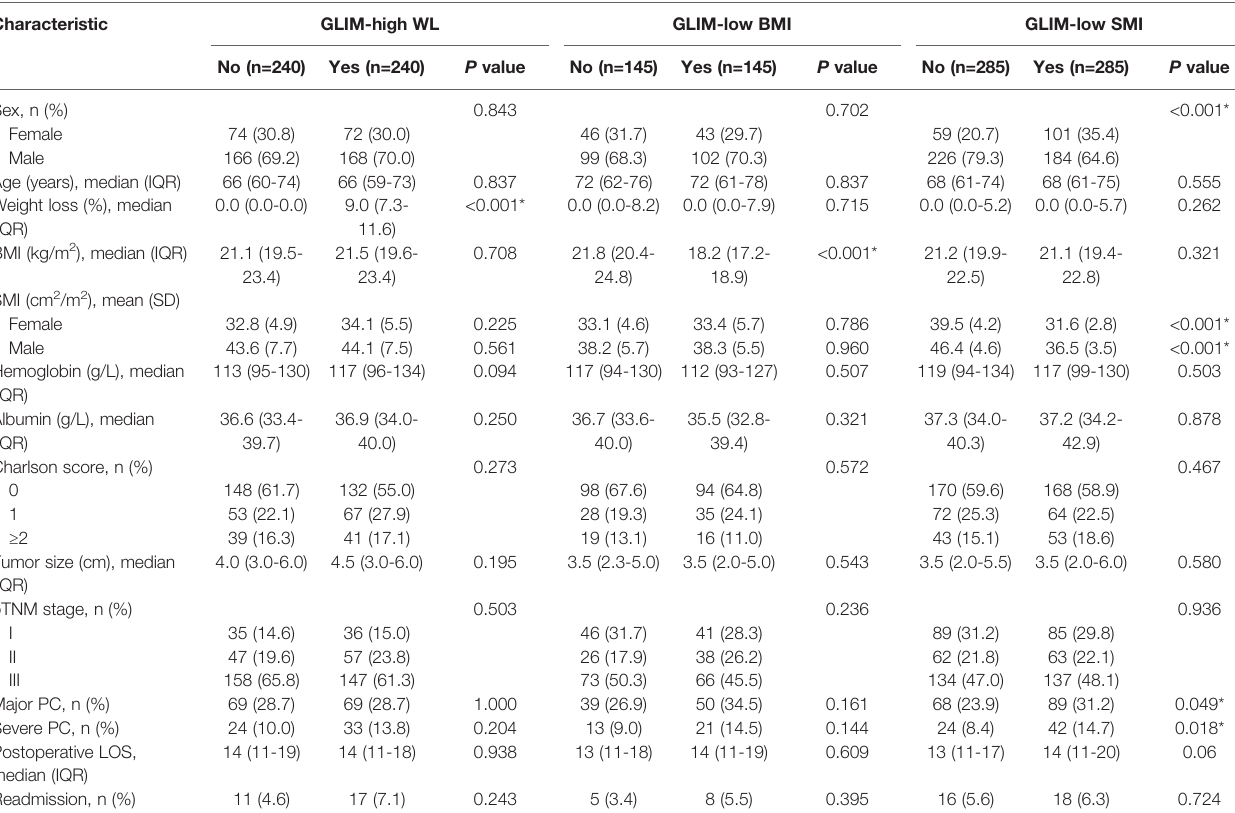
TABLE 2 | Patient baseline characteristics in the propensity score-matched cohort.